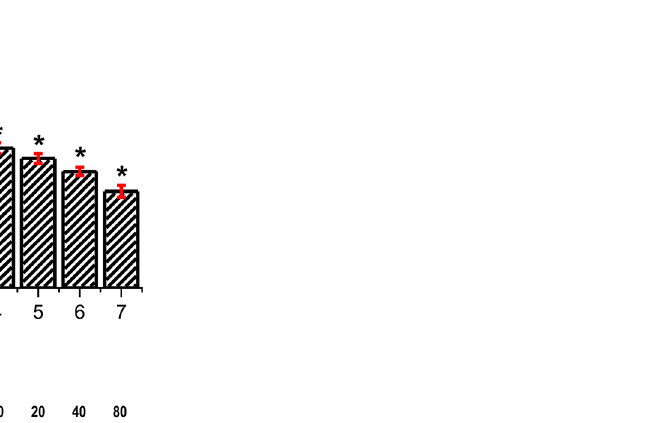
Figure 9. Viability test of neuroblastoma cells treated with MSN (100 µg mL −1 ), MSN-AmEA (100 µg mL −1 ), and Que@MSN-AmEA contained quercetin at concentration of 10, 20, 40 and 80 µM for 24